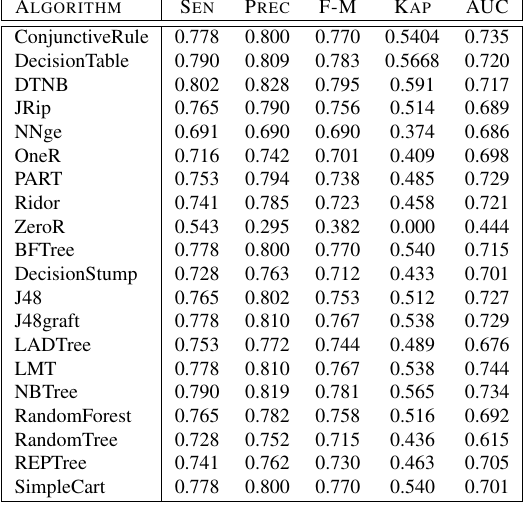
Table 2: Algorithms’ performance for